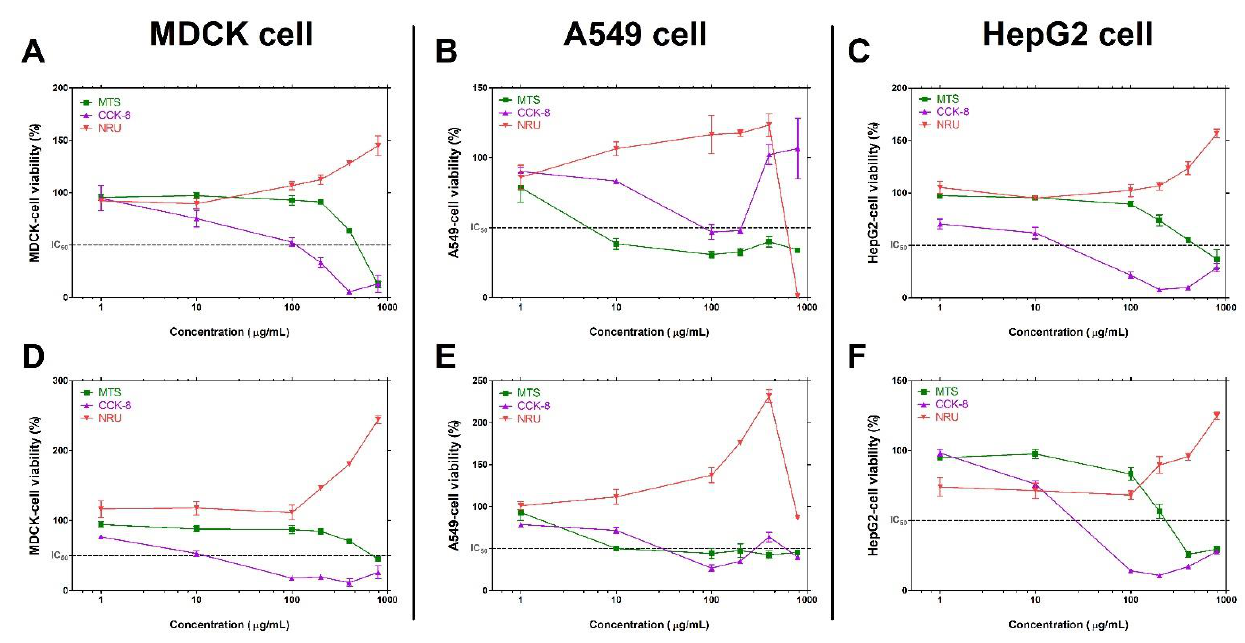
Figure 3. The comparison with results of colorimetric cytotoxicity assays treated with graphene nanomaterials. The cytotoxicity results of GNPs-1 in ( A ) MDCK, ( B ) A549 and ( C ) HepG2 cells. The cytotoxicity results of GNPs-2 in ( D ) MDCK, ( E ) A549, ( F ) HepG2 cells. Data are expressed as mean ± SEM ( n = 3).